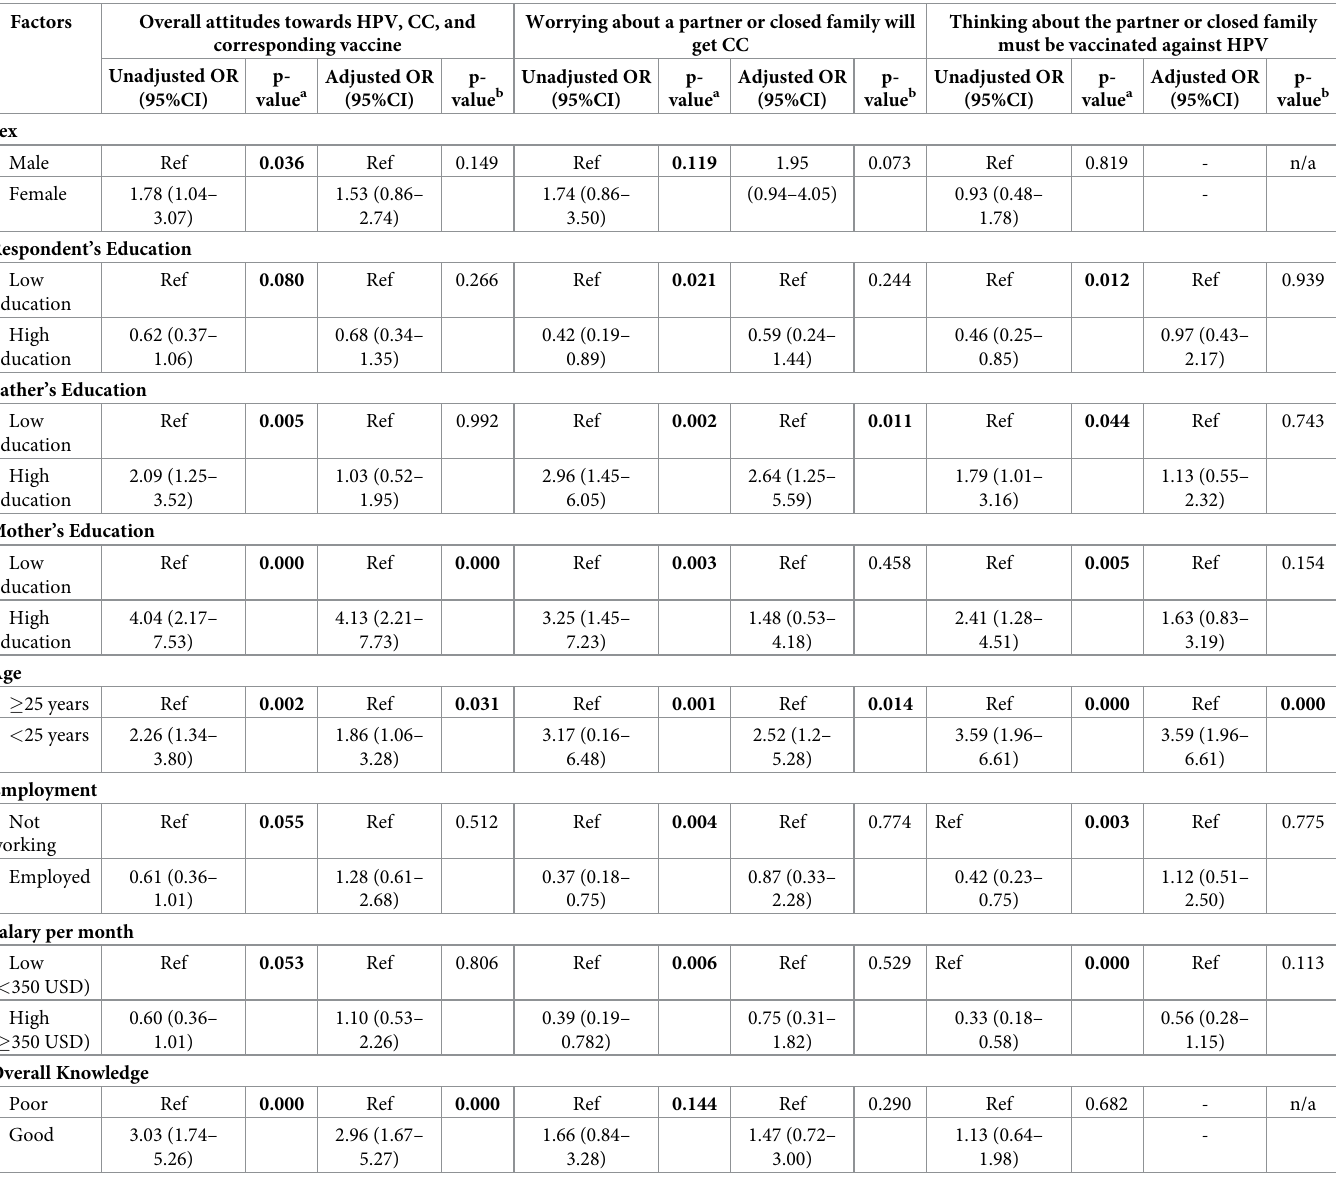
a Bivariate analysis using Chi-square and Mantel-Haenszel odds ratio estimate, any associated factors with p � 0.20 were deemed eligible for inclusion in the multivariate analysis model; b Multivariate logistic regression analysis; 95%CI (95% confidence